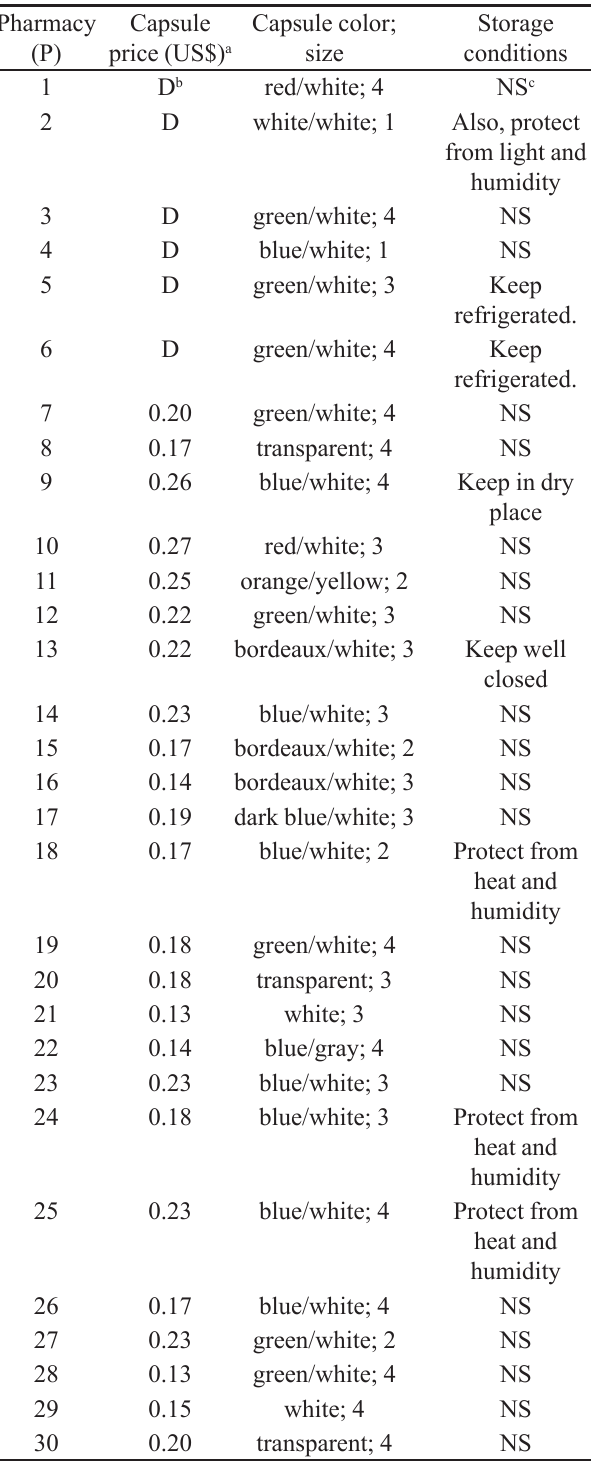
TABLE I – Description of simvastatin 20 mg capsule batches acquired from thirty compounding